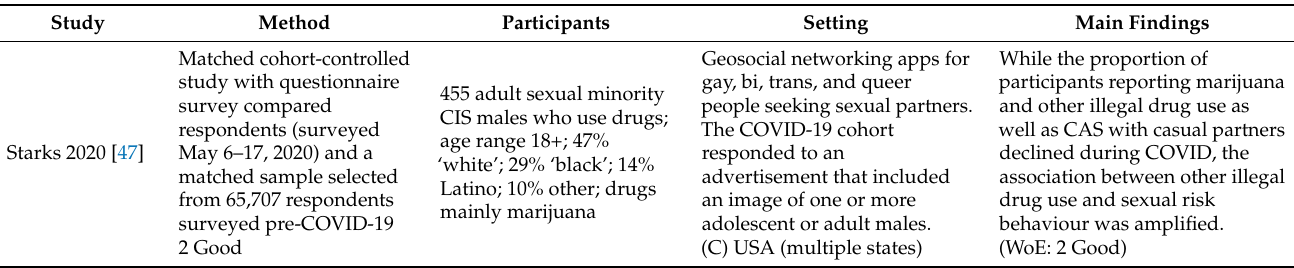
Table 10. Sexual minority